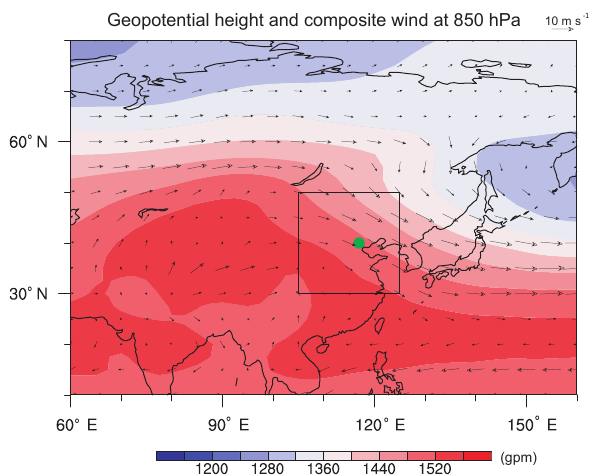
Figure 1. Climatological mean of geopotential height (shading, units: gpm) and composite wind speed (vectors) at 850hPa in winter over East Asia during 1980–2016. The outlined region (30–50 ◦ N, 105–125 ◦ E) is used to calculate a regional mean climatological background around Beijing (green dot, 40 ◦ N, 117 ◦